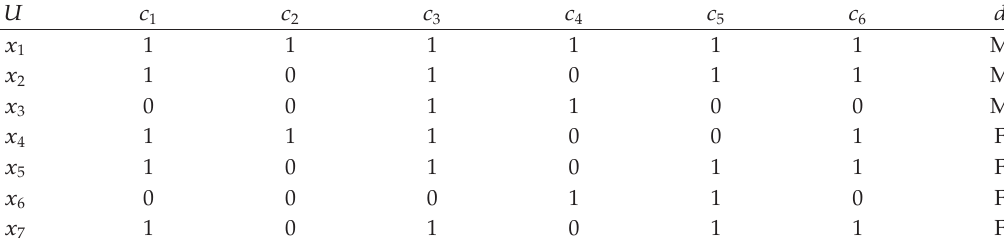
Table 1: A decision